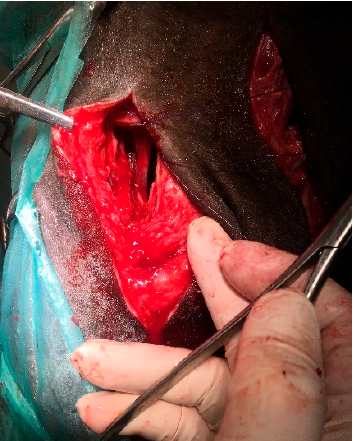
Figure 5. Intraoperative view. Dorsal approach to the caudal part of the tumor by the osteotomy of a 2 × 5 cm bone fragment dorsally to the infraorbital foramen.